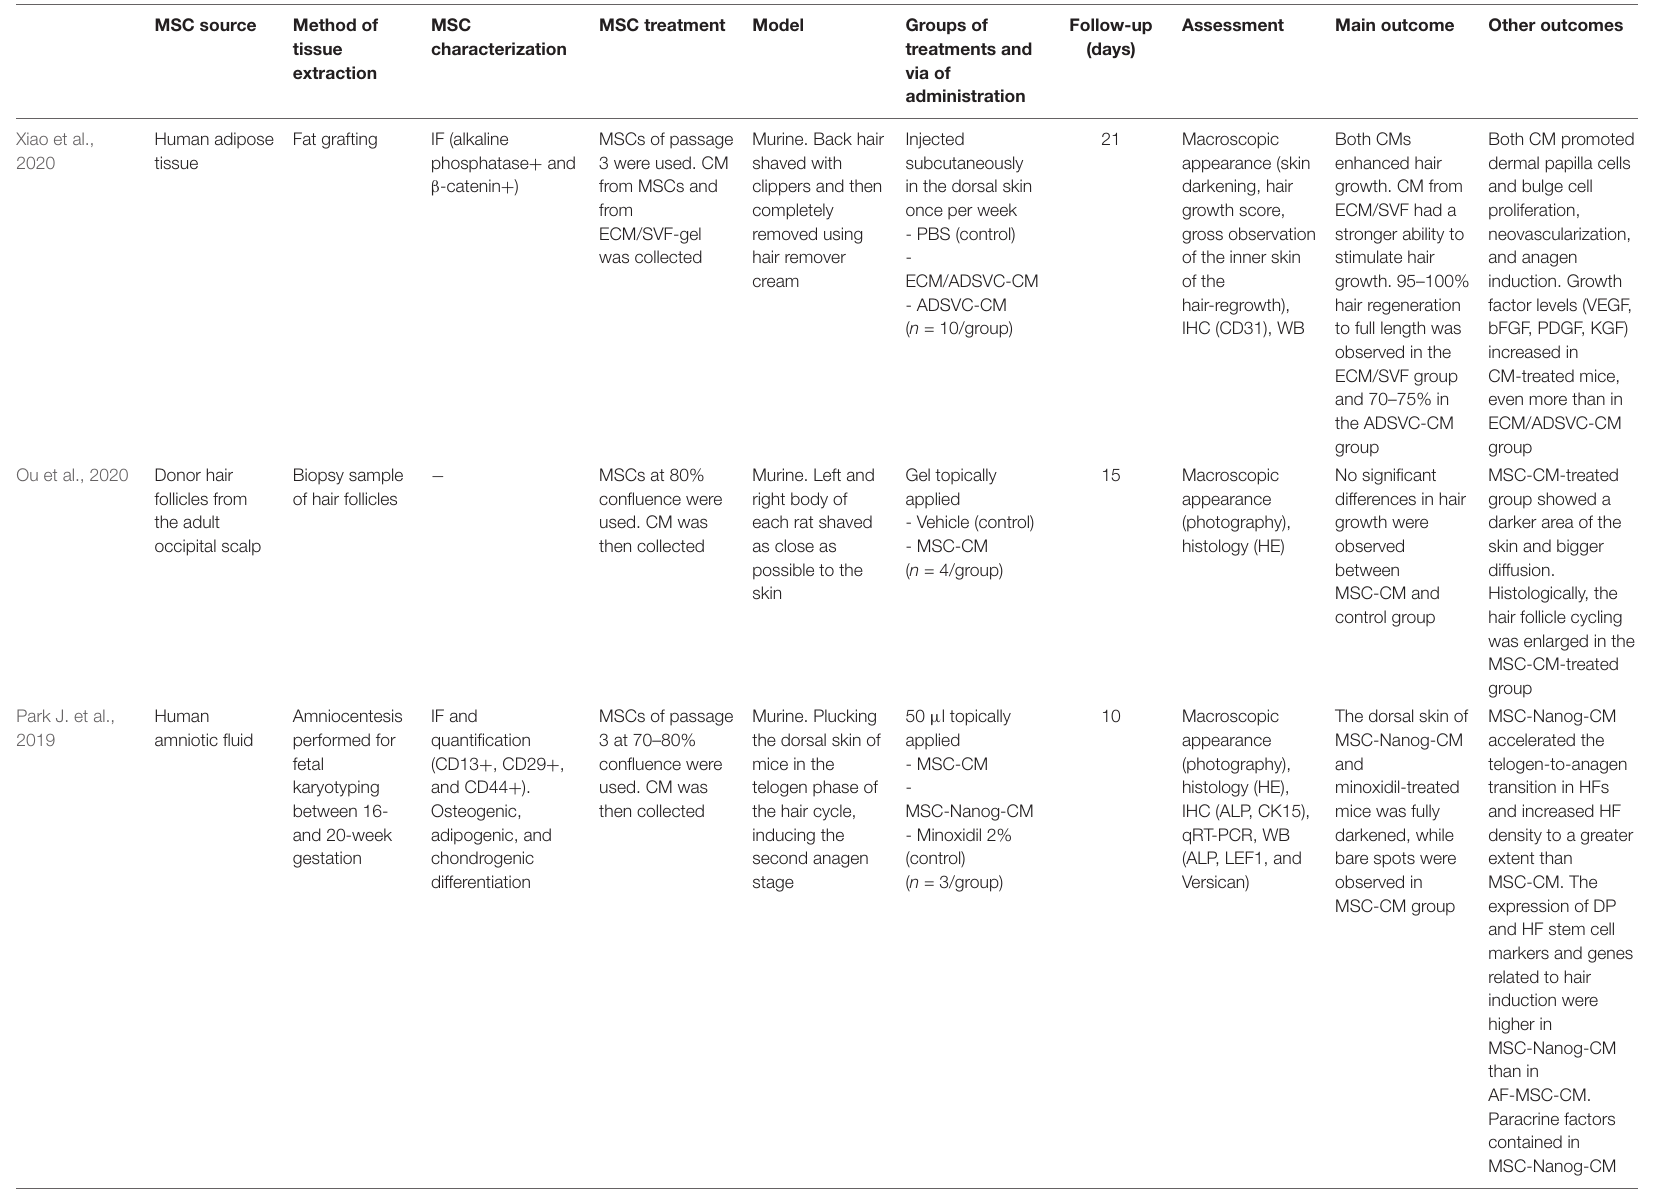
TABLE 7 | Studies regarding mesenchymal stromal cell-conditioned medium for hair restoration in animal